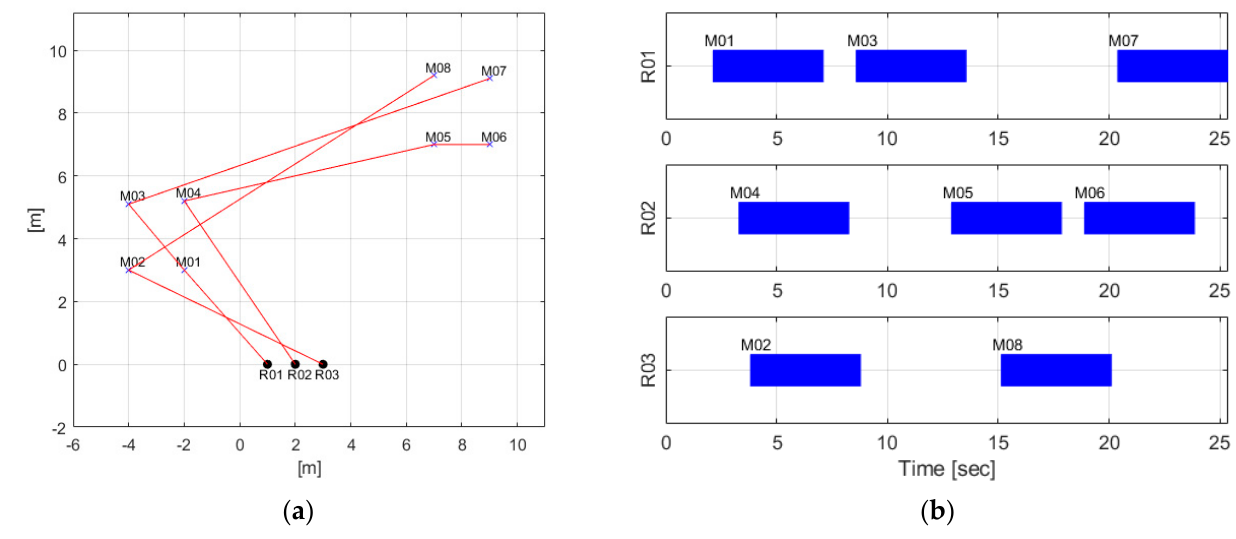
Figure 2. The results for simple case using TACTAR: ( a ) 2D situation map; ( b ) timetable.